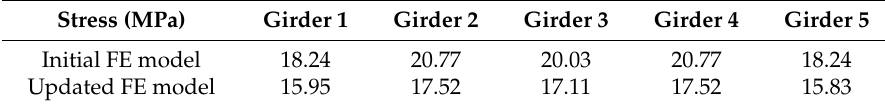
Table 2. Maximum stress ranges of girders from initial and updated FE